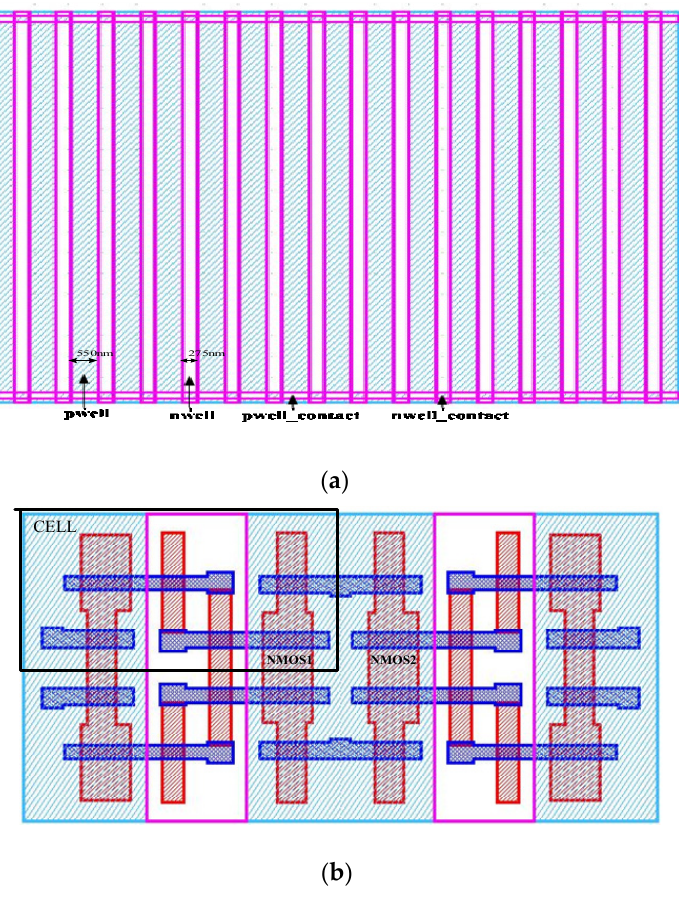
Figure 6. ( a ) Layout of the SRAM, ( b ) structural layout of the 6 transistors cell.